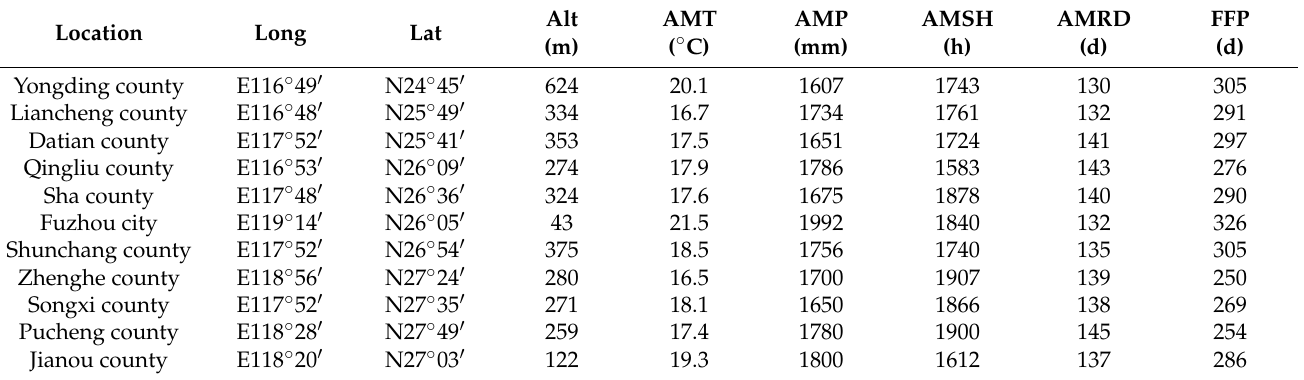
Table 2. Environmental factors of each location of H. acerba trees.